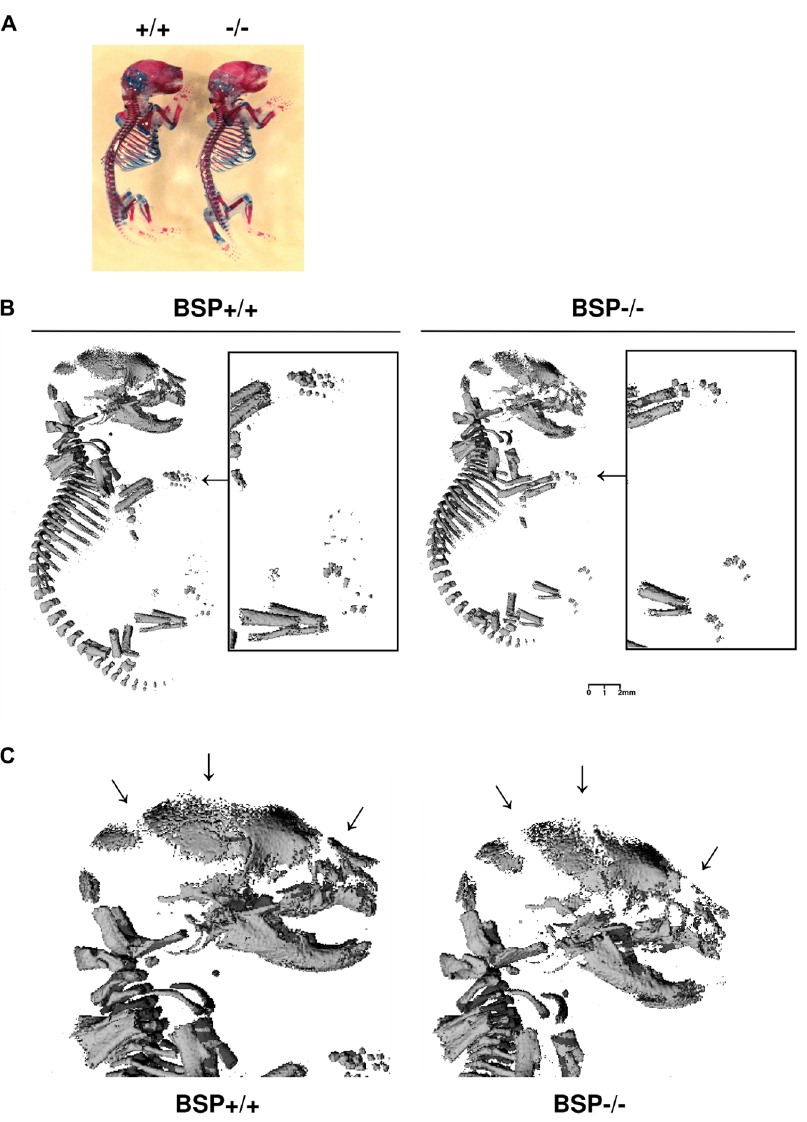
Figure 2. Skeletal development and mineralization of newborn BSP + / + and BSP 2 / 2 mice. (A) Skeletal preparation (alcian blue/alizarin red staining) of BSP + / + ( + / + ) and BSP 2 / 2 ( 2 / 2 ) E19 mice. (B) 3D m CT reconstruction of whole newborn + / + and 2 / 2 mice, showing undermineralized fingers (arrows and black-bordered detailed pictures), and (C) high magnification of the heads showing the widened sutures (arrows).